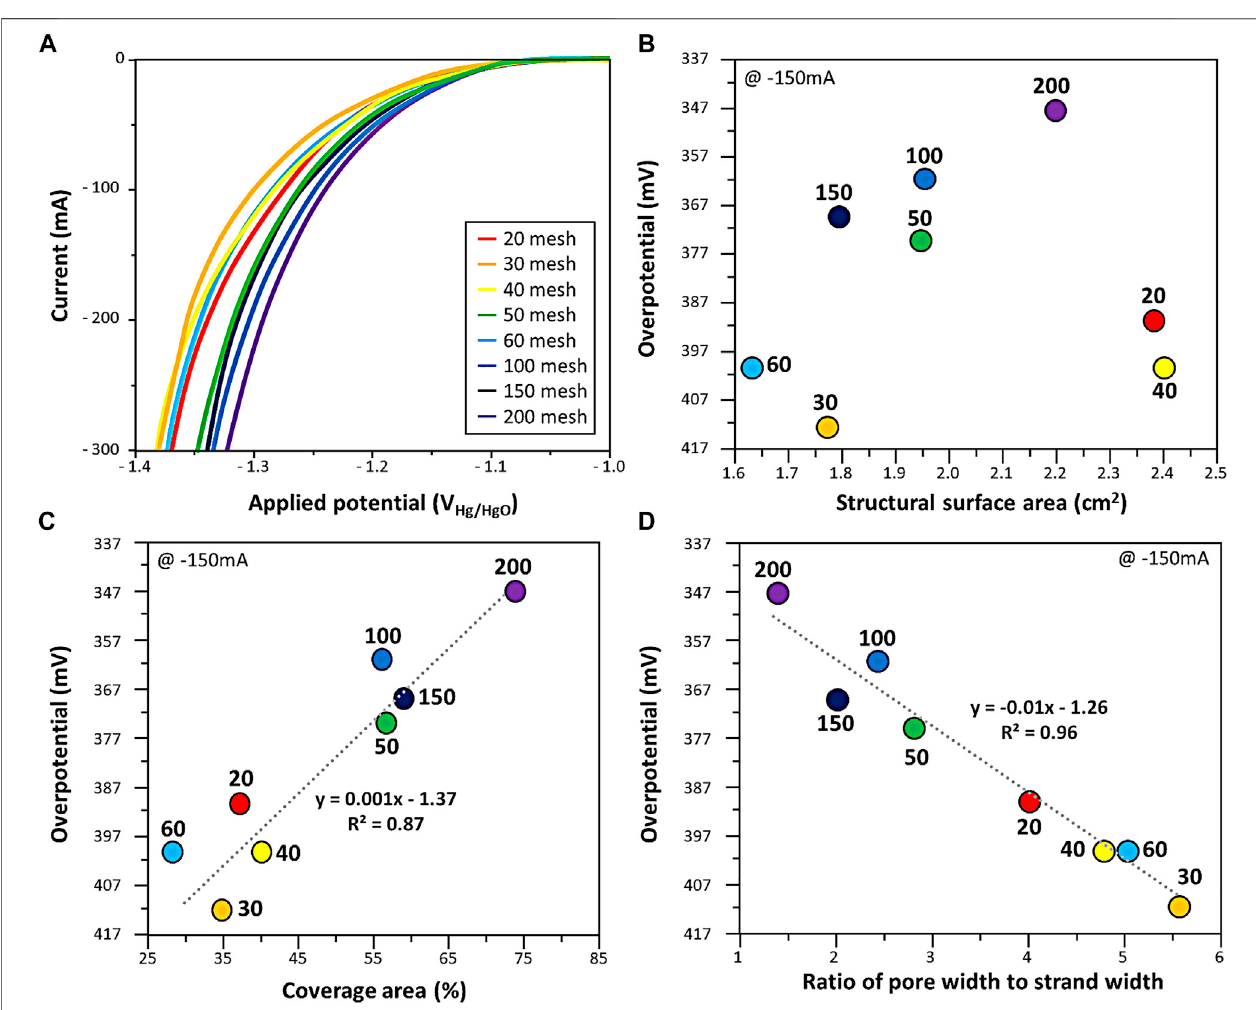
FIGURE 2 | (A) HER performance of woven mesh. The overpotential at 150 mA current in HER with respect to (B) structural surface area, (C) coverage area, and (D) ratio of pore width to strand width of woven mesh. The dotted line is the linear regression plot obtained from the data.